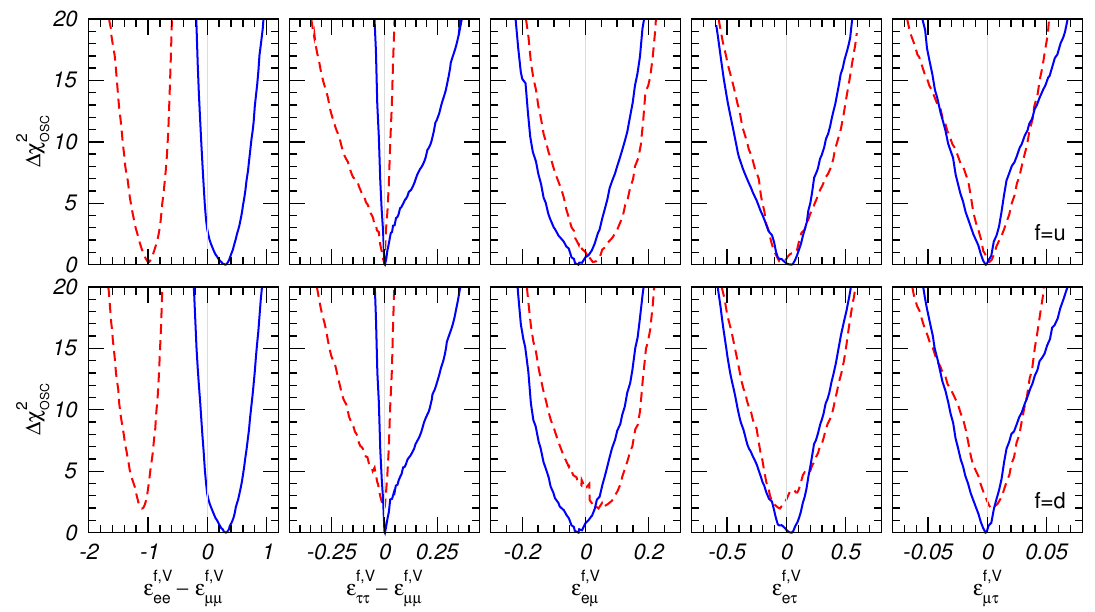
Figure 1 . Dependence of the (cid:1) (cid:31) 2 function for the global analysis of solar, atmospheric, reactor OSC and LBL data on the NSI parameters (cid:15) f;V for f = u (upper panels) and f = d (lower panels). Solid (cid:11)(cid:12) curves correspond to the standard LMA solution and dashed curves correspond to the LMA-D degeneracy. These results correspond to the current limits assuming light NSI mediators. Results adopted from ref.